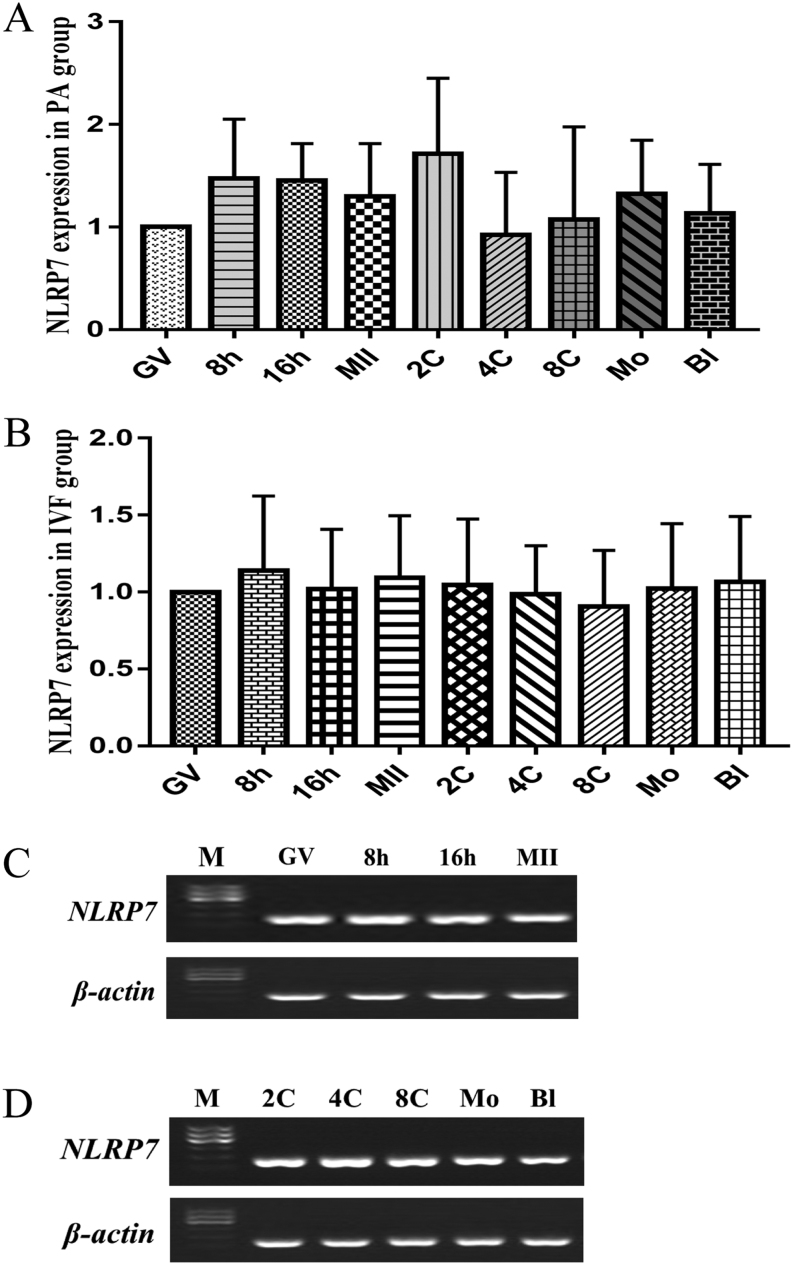
Expression pattern of NLRP7 mRNA in IVM oocytes and PA/IVF embryos.(A) Relative abundance of NLRP7 transcripts in samples collected from GV (germinal vesicle), 8 h, 16 h, MII (Metaphase II) stage oocytes and PA (parthenogenetic activation) 2-cell (2C), 4-cell (4C), 8-cell (8C), morula (Mo) and blastocyst (Bl) stage embryos (n = 4 pools of 20 each). (B) Relative abundance of NLRP7 transcripts in samples collected from GV (germinal vesicle), 8 h, 16 h, MII (Metaphase II) stage oocytes and IVF 2-cell (2C), 4-cell (4C), 8-cell (8C), morula (Mo) and blastocyst (Bl) stage embryos (n = 4 pools of 20 each). (C) RT-PCR of NLRP7 in IVM oocytes.(D) RT-PCR of NLRP7 in PA embryos. M, Marker. β-actin was used as an internal control.